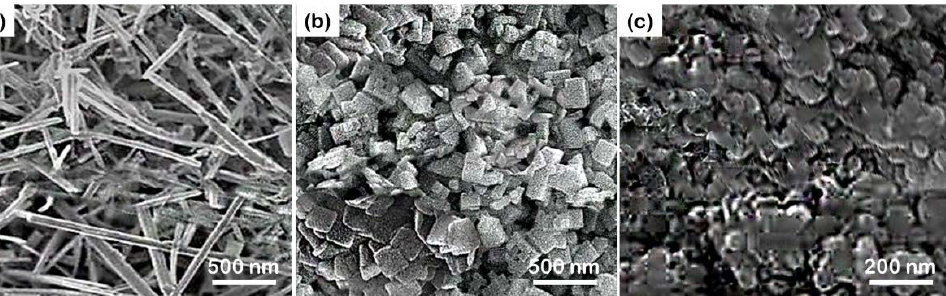
Figure 8. SEM micrographs showing the various morphologies of WO3 photocatalysts: ( a ) nanoplates, ( b ) nanorods, and ( c ) nanospheres.